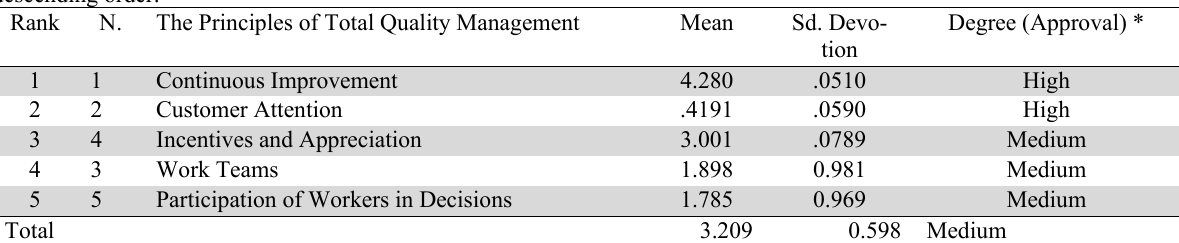
Arithmetic averages and standard deviations of employees' perceptions of the principles of total quality management are in descending